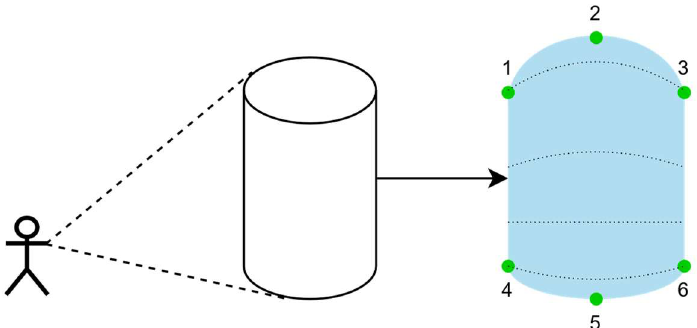
Figure 2. Cylindrical Warp Model.